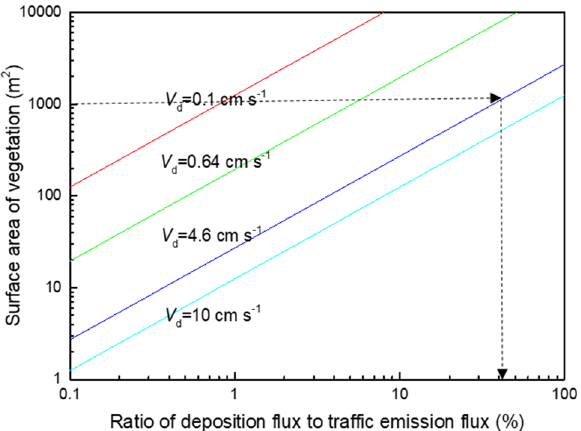
Figure 1. Ratio of vegetation deposition flux to traffic emission flux; depending on surface area of vegetation with differing leaf deposition velocity ( V d ) in a street canyon of 100 m length with annual PM 10 concentration of 37 µg m −3 , average emission factor 100 µg vehicle −1 m −1 for PM 10 , traffic intensity of ~ 40,000 vehicles day −1 (adapted from 56,58 ). The black dashed lines indicate the % PM 10 removal (~ 40%) by leaf deposition, with 8 silver birch trees ( V d = 4.6 cm s −1 , canopy diameter 8 m, total leaf surface area = 125 m 2